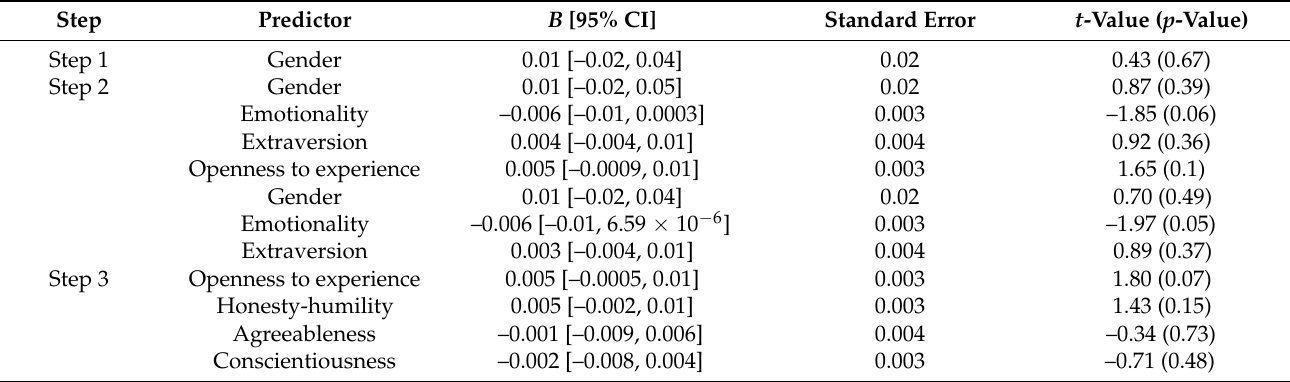
Table 3. Results of the hierarchical regression analysis with the adaptation of trust behavior in the trustworthy condition as the outcome